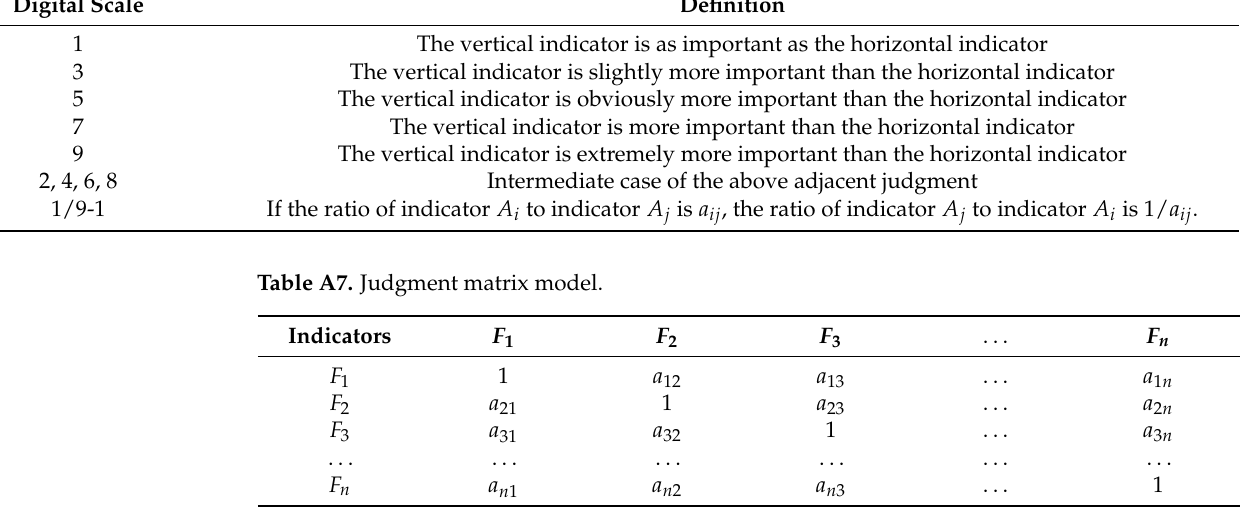
Table A8. Judgment matrices and weights of first-level assessment indicators.